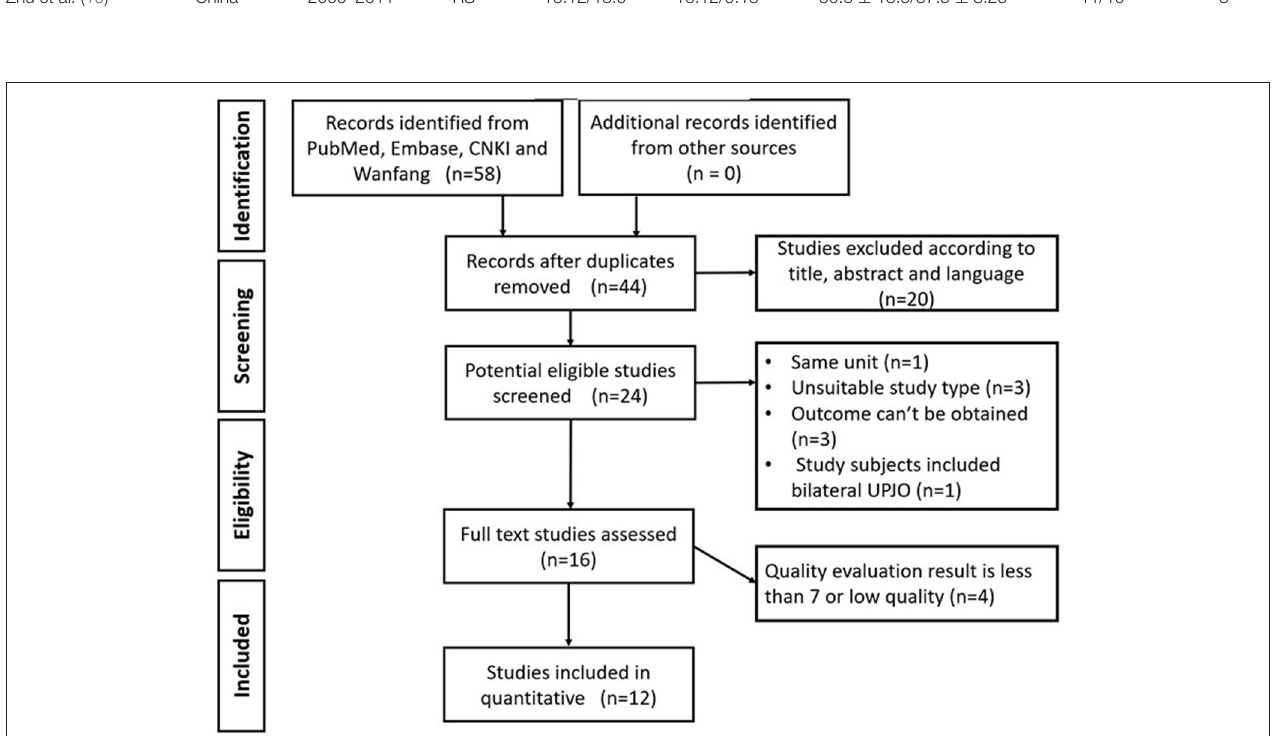
FIGURE 1 | Search process of the studies.